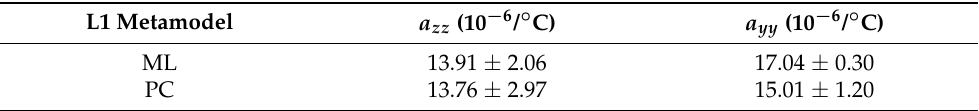
Table 1. Thermal expansion coefficient estimated by the minimization of the L1 metamodels (ML and PC) along the direction Z ( a zz ) and Y ( a yy